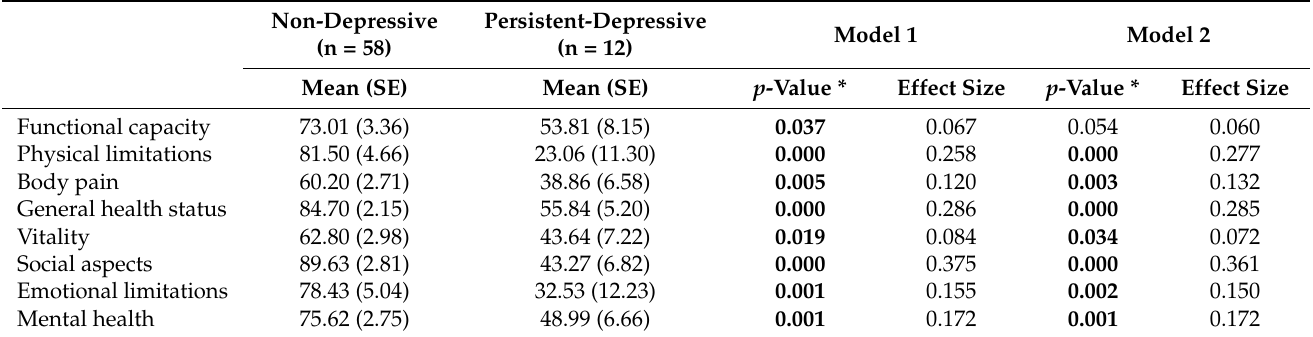
Table 3. Multiple comparison models of quality-of-life domain scores after a 12-month follow-up between depressive and non-depressive breast cancer survivors (n =